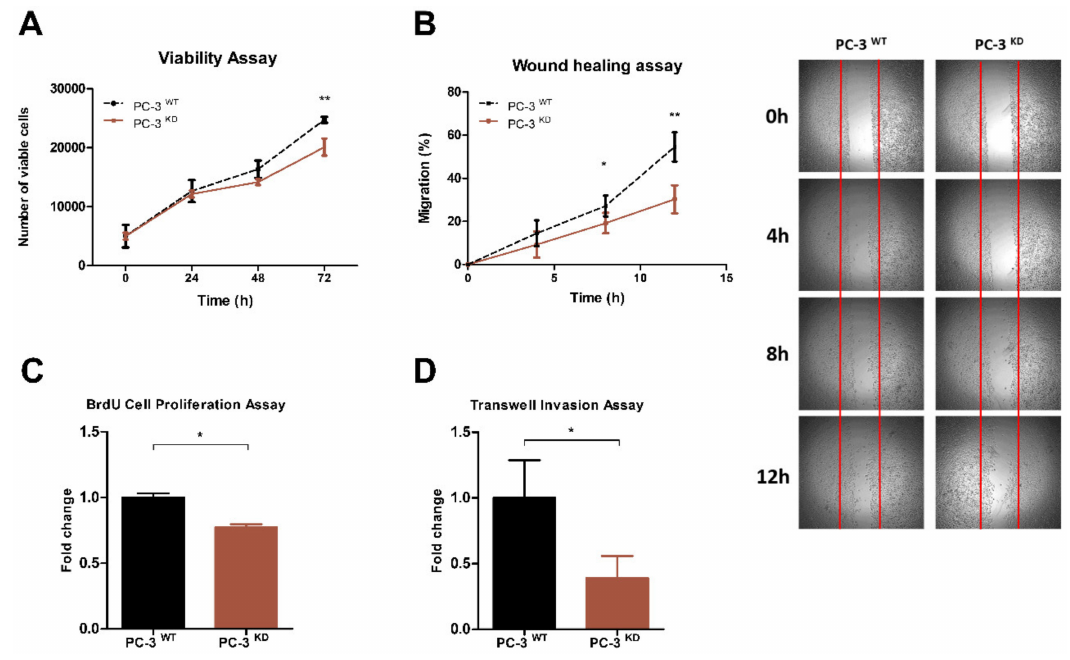
Figure 4. VIRMA expression promotes PC-3 cells growth and progression in vitro. ( A ) MTT assay for the number of viable PC-3 WT and PC-3 KD cells at 24 h, 48 h, and 72 h after seeding. ( B ) Quantitation of Wound-healing assay for PC-3 WT and PC-3 KD . Points and connecting line on the left panel represent the migration index of wound-healing assay over the course of 12 h. The distance migrated by PC-3 KD cells is represented as relative to that migrated by PC-3 WT cells in the same time period. Representative photos are shown in the panel on the right. ( C ) Proliferation of PC-3 WT and PC-3 KD cells assessed by BrdU assay at 24 h. ( D ) Invasion of PC-3 WT and PC-3 KD cells assessed by Matrigel transwell assay at 24 h. Column bars in (C) and (D) represent the average number of cells from 3 independent experiments. Error bars represent ± SD. ** p < 0.001 * p < 0.05, Mann–Whitney U